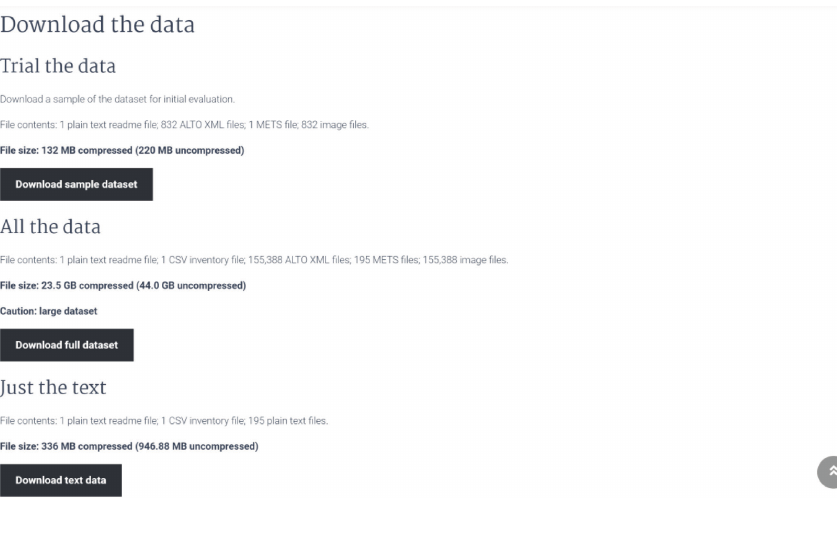
Fig. 3: Tiered dataset downloads on the Data Foundry